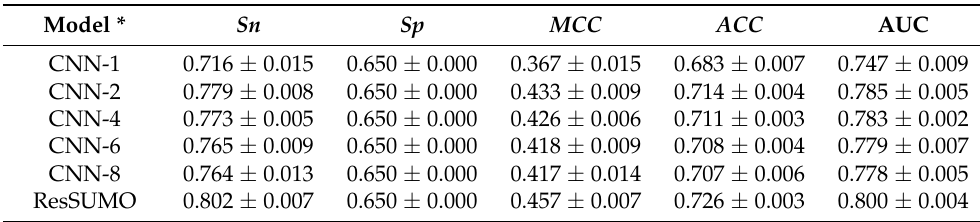
Table 3. Performance of ResSUMO and the CNN models with different numbers of convolution layers in five-fold cross-validation. Model